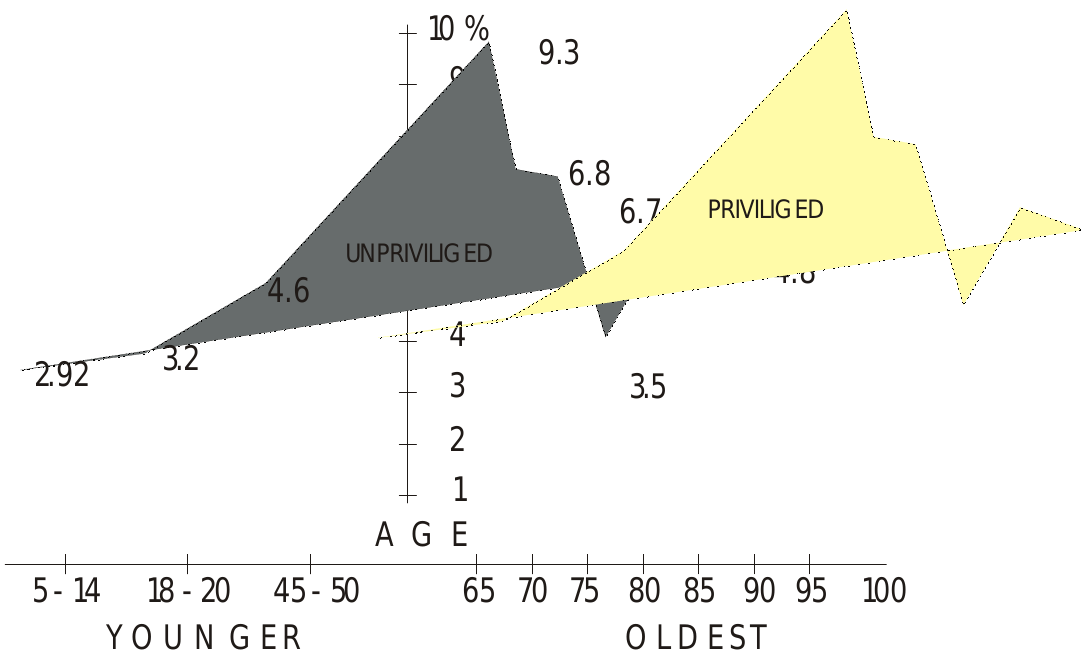
FIGURE 1 . The rise of the chromosome aberrations in the “privileged” group is hypothetically